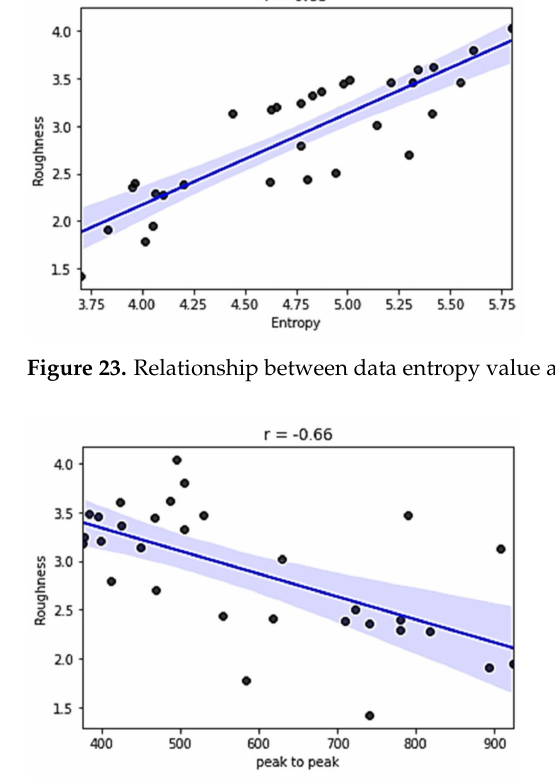
Figure 24. Relationship between data peak-to-peak value and